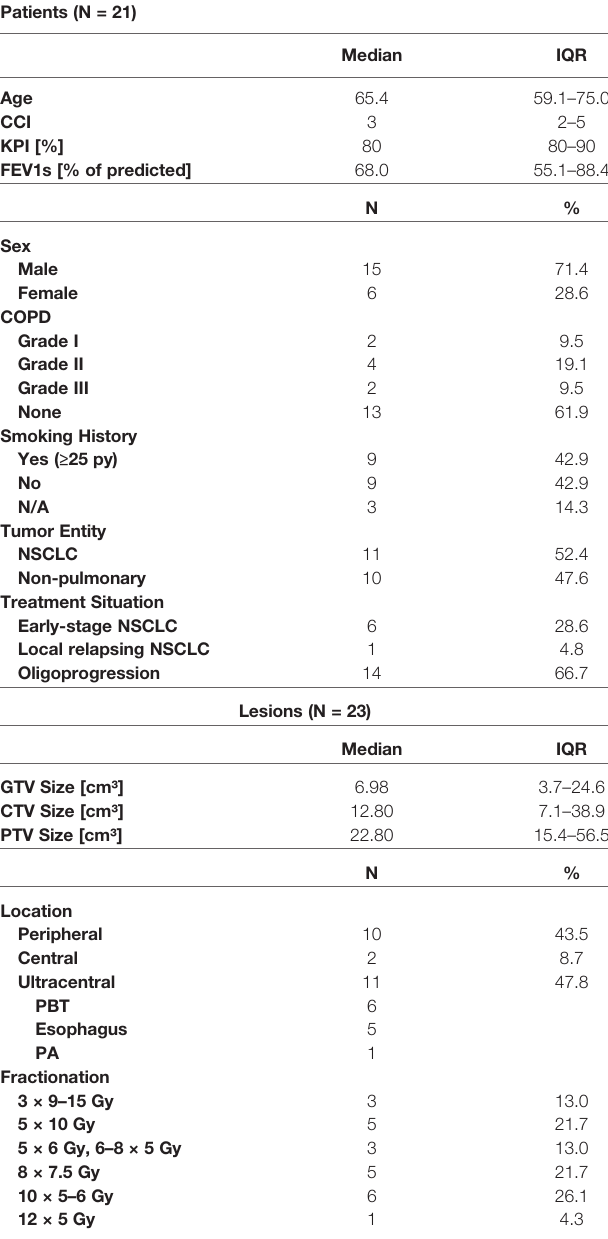
TABLE 1 | Patient and treatment characteristics. Patients (N =